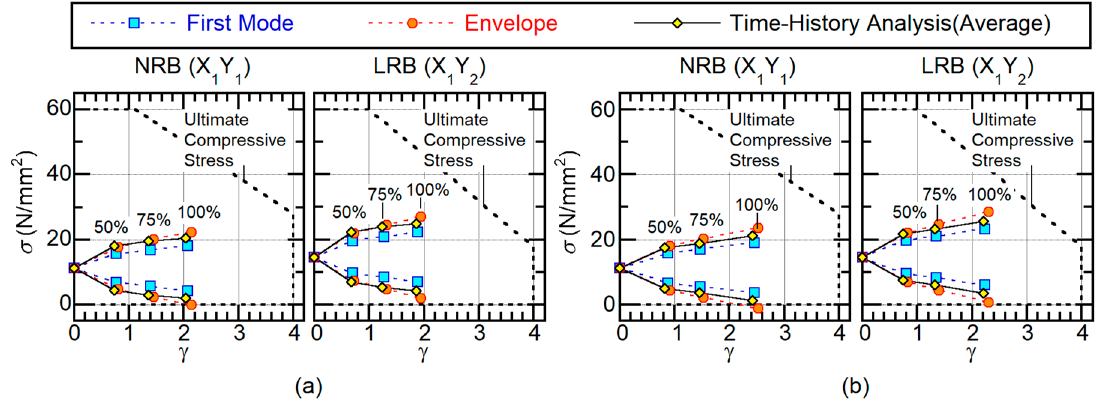
Figure 16. Comparisons between maximum responses of isolators: ( a ) Art-S series; ( b ) Art-L series.